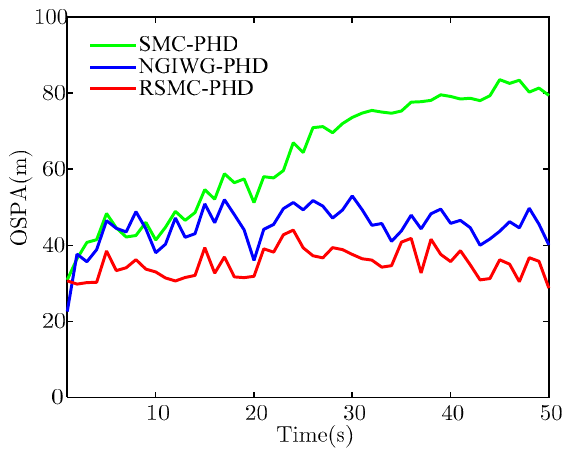
Figure 6. The estimate of OSPA.